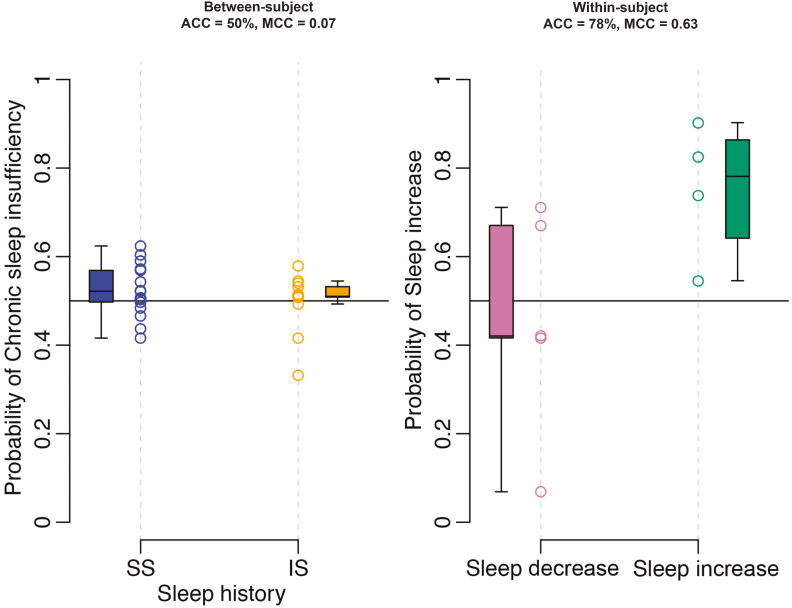
Classification performance for “chronic sleep insufficiency” between- and within-subject. “Between-subject” refers to the classification of a single transcriptome sample to two classes: following sufficient sleep (SS) or following insufficient sleep (IS). Data shown based on the final “all features” elastic net model trained on all samples #1 (or #2) within the “UPUS” training set and applied to all samples #1 (or #2) within the corresponding independent validation set. “Within-subject” refers to the classification of a differential transcriptome sample to two classes: sleep decrease or sleep increase. Data shown based on the final “all features” elastic net model trained on all “visit 1”–“visit 2” samples, using samples #2 (or #3), within the “UPUS” training set and applied to all “visit 1”–“visit 2” samples, using samples #2 (or #3) within the corresponding independent validation set. Black horizontal line represents the decision boundary for classifying a sample at a probability of 0.5. ACC = accuracy.